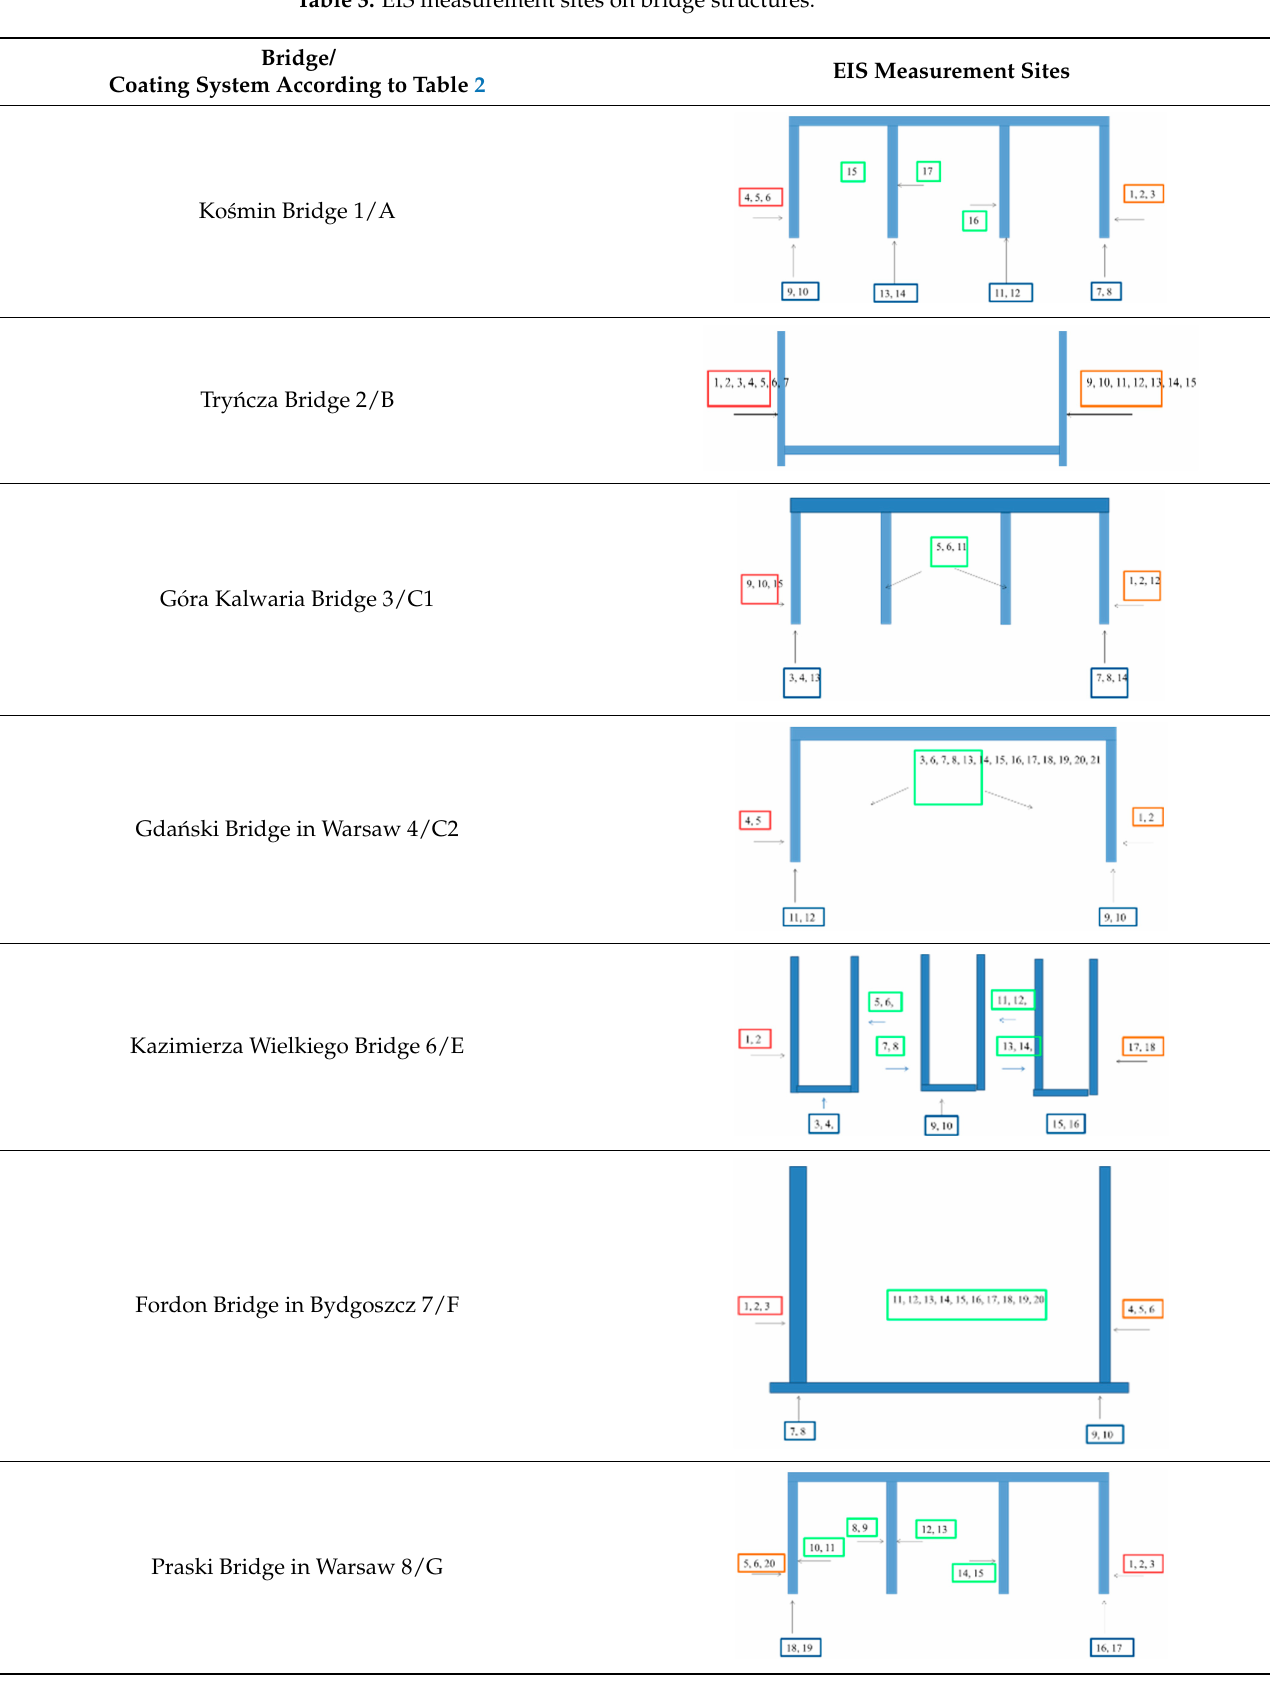
Table 3. EIS measurement sites on bridge